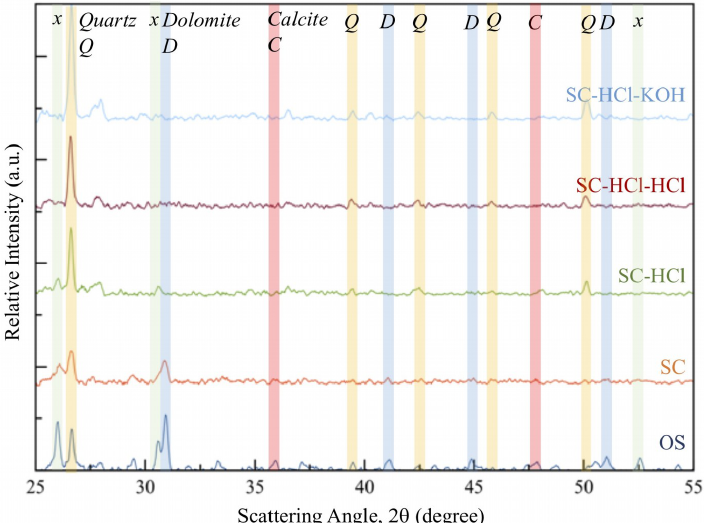
Figure 4. Cu-K α X-ray diffraction pattern of raw, semi-coke, and demineralized samples. Q, D, and C indicate Quartz, Dolomite, and Calcite, respectively. x was suggested by analysis software as pollucite, which is unlikely given its zeolite structure and non-natural occurrence.